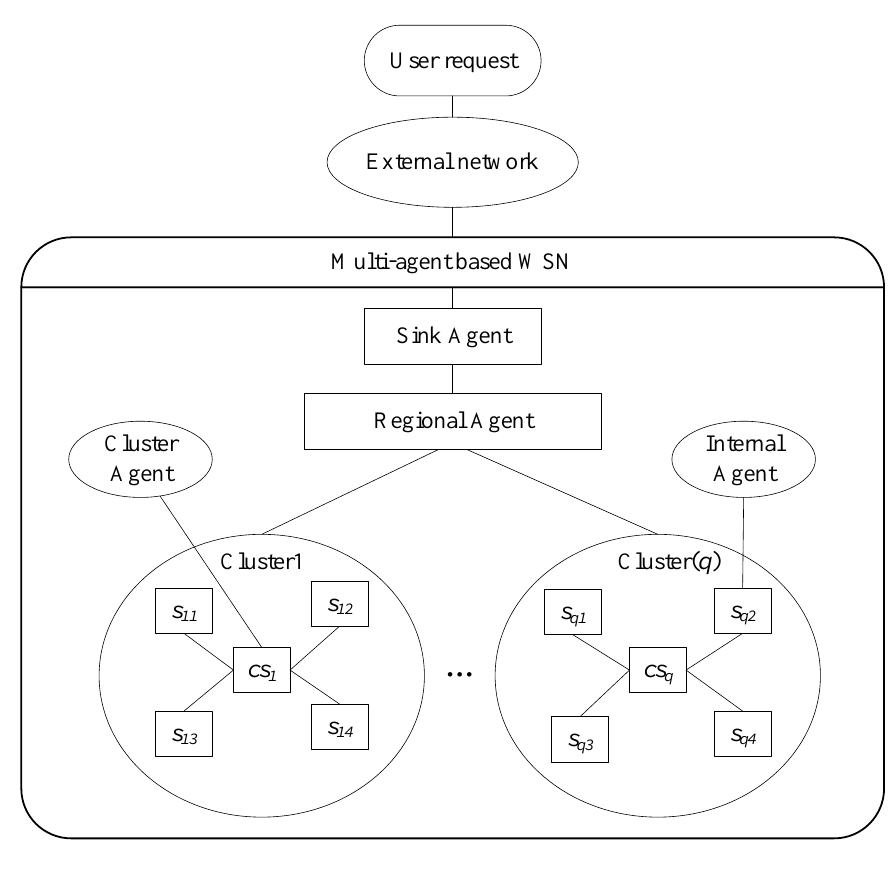
Figure 1. The multi-agent-based system architecture for